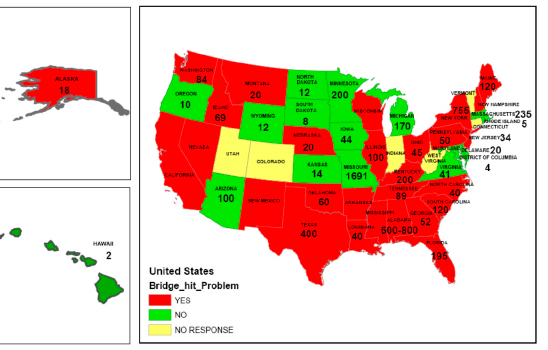
Figure 1. Number of bridge impacts between 2005 and 2008 across the United States [2].